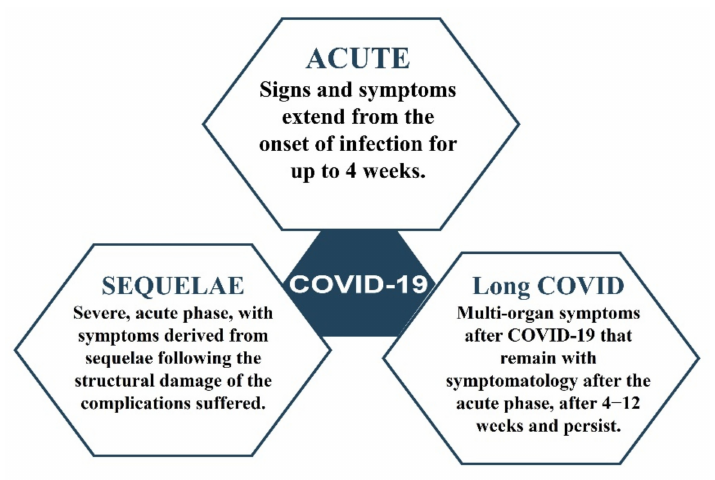
Figure 1. Long COVID, Sequelae of COVID-19 and Acute